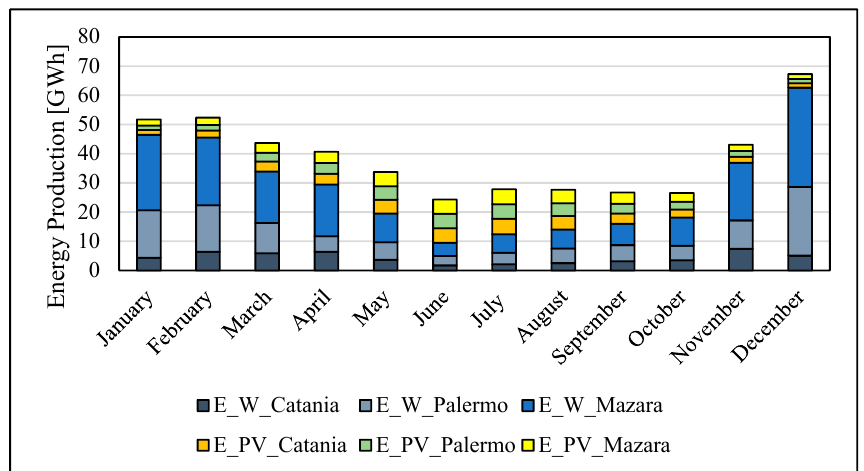
Figure 13. Annual electrical production in scenario 2% (Case A). Energies 2017 , 10 , 376